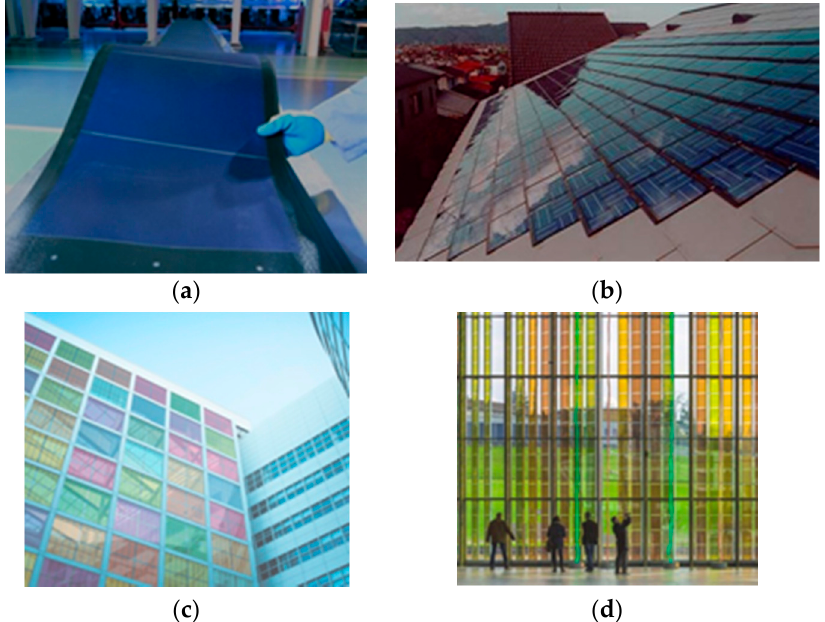
Figure 6. Third generation BIPV products: ( a ) foil ; ( b ) tiles ; ( c ) module on façade ; ( d ) solar glazing .